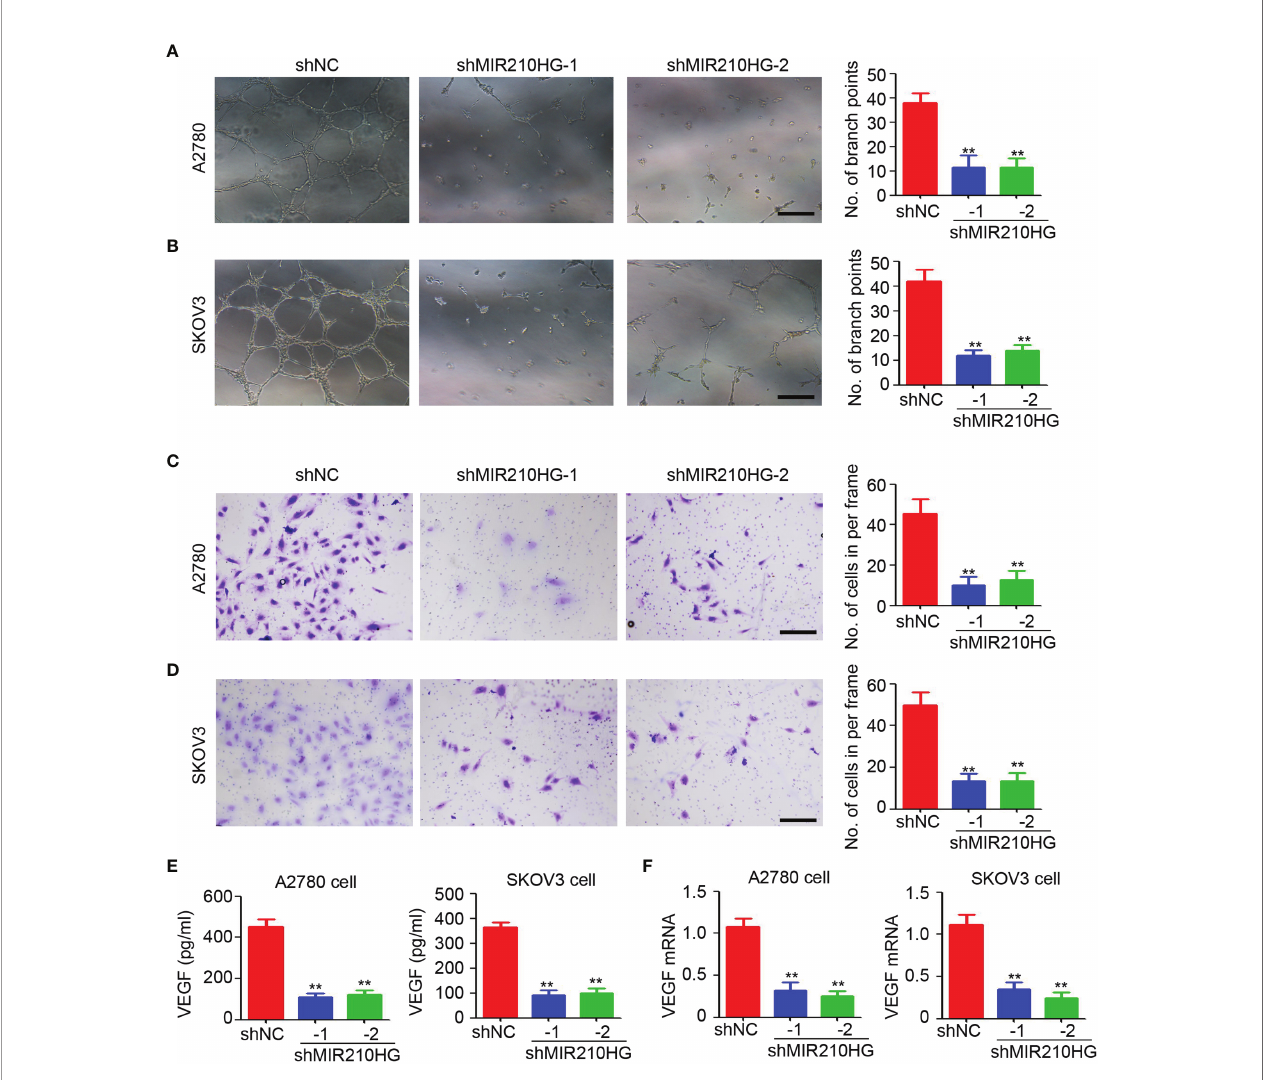
FIGURE 3 | lncRNA-MIR210HG promotes angiogenesis in ovarian cancer. (A, B) The conditional culture medium from A2780-shNC, A2780-shMIR210HG, SKOV3- shNC and SKOV3-shMIR210HG cells that were cultured under hypoxia condition were collected for HUVECs tube formation assay. The number of branch points formed in each frame was counted and analyzed (n = 4, **p < 0.01, Scale bar = 100 m m). (C, D) The conditional culture medium from A2780-shNC, A2780- shMIR210HG, SKOV3-shNC and SKOV3-shMIR210HG cells that were cultured under hypoxia condition were collected for HUVECs migration assay. The number of migrated cells in each frame was counted and analyzed (n = 4, **p < 0.01, Scale bar = 100 m m). (E) ELISA detection of VEGF expression in conditional culture medium from A2780-shNC, A2780-shMIR210HG, SKOV3-shNC and SKOV3-shMIR210HG cells that were cultured under hypoxia condition (n = 3, **p < 0.01). (F) qPCR analysis of VEGF mRNA expression in A2780-shNC, A2780-shMIR210HG, SKOV3-shNC and SKOV3-shMIR210HG cells that were cultured under hypoxia condition (n = 3, **p <